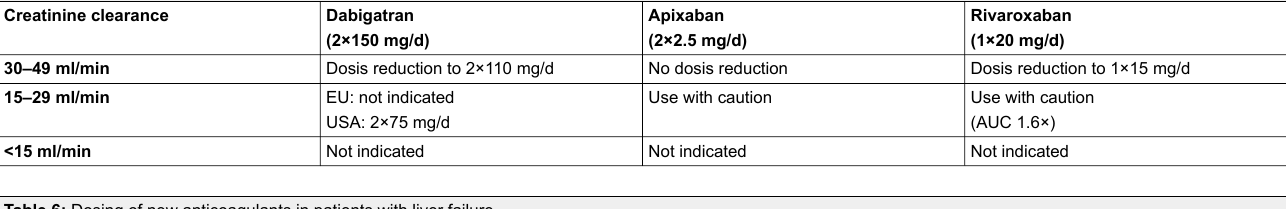
Table 6: Dosing of new anticoagulants in patients with liver failure. Liver failure Dabigatran (2×150 mg/d) Mild Child A/B Contra-indicated Use with caution Use with caution ALT/AST >2× Bilirubin >1× Severe with or without coagulopathy Contra-indicated Contra-indicated